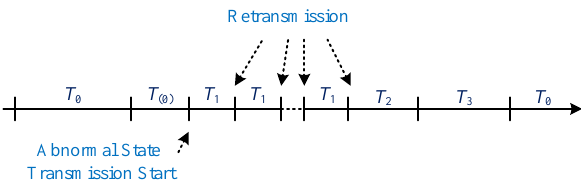
Figure 6. The retransmission mechanism of the generic object-oriented substation event (GOOSE).